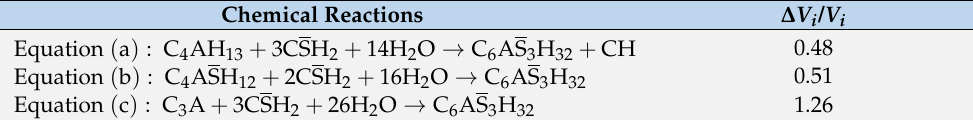
Table 4. Coefficients of volume change in concrete caused by chemical reactions. Chemical Reactions ∆ V i / V